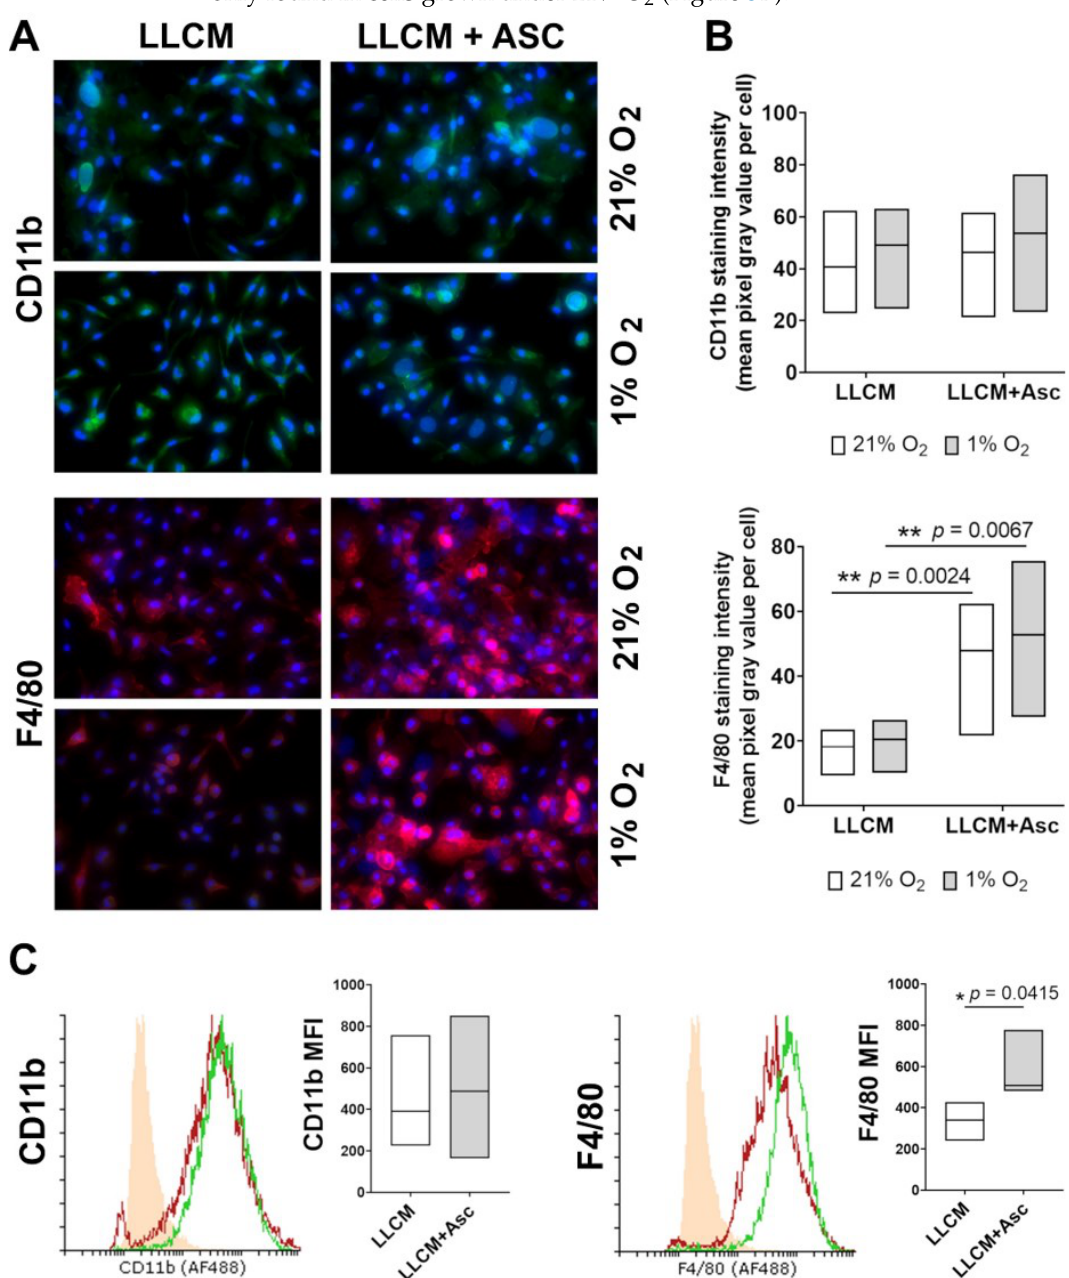
Figure 1. Characterization of cell surface markers of bone marrow cells grown in vitro. ( A ) Immunofluorescent staining of CD11b and F4/80 on bone marrow cells grown in LLCM with or without ascorbate (500 µ M). Isolated bone marrow cells were grown for 7 days at ambient air (21% O 2 ) or subjected to hypoxia (1% O 2 ) on day 6 for ~18 h. Cells were then fixed and stained in situ for CD11b (green) and F4/80 (red); blue denotes DAPI staining for DNA. Microscope images (30 × ) are representative of results from one experiment (cells from one mouse). IgG control is shown in Appendix A, Figure A1. All growth conditions showed positive staining for CD11b and F4/80 in the majority of cells. ( B ) Densitometry analysis of CD11b and F4/80 immunostained cells represented by the mean gray pixel values per cell from 4 random fields of view per experiment (3 mice). CD11b staining did not show any statistical difference between groups. Cellular F4/80 staining was statistically more intense in the LLCM + Asc groups compared to LLCM group at the corresponding oxygen tensions. Two-tailed paired t -tests were performed, ** denotes p < 0.01. ( C ) Flow cytometric analysis of CD11b and F4/80 on